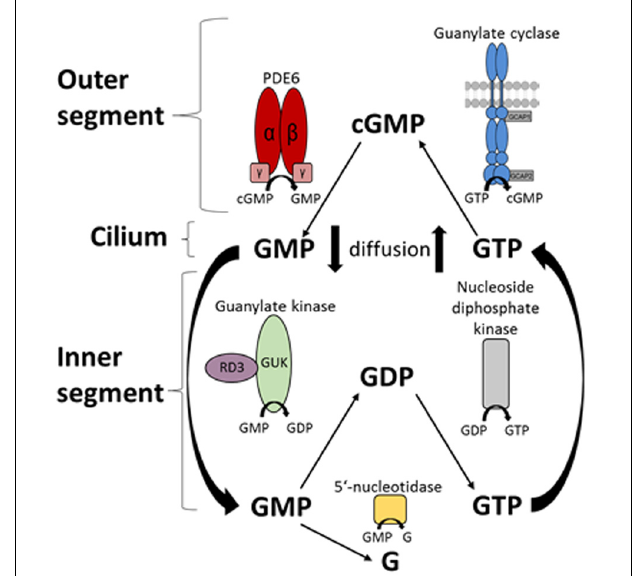
FIGURE 7 | Schematic overview of the nucleotide cycle in photoreceptor cells. Cyclic GMP is the second messenger of photoreceptor excitation. After light-triggered degradation to 5 (cid:48) -GMP by the PDE6, 5 (cid:48) -GMP diffuses to the inner segment of the photoreceptor. Here it can be further degraded to guanosine or is recycled by the guanylate kinase (GMP → GDP) and the nucleoside diphosphate kinase (GDP → GTP). RD3 interacts with GUK and upregulates its activity. GTP then diffuses back to the outer segments, where the enzymes of the phototransduction cascade use it, specifically the GCs synthesizing cGMP from